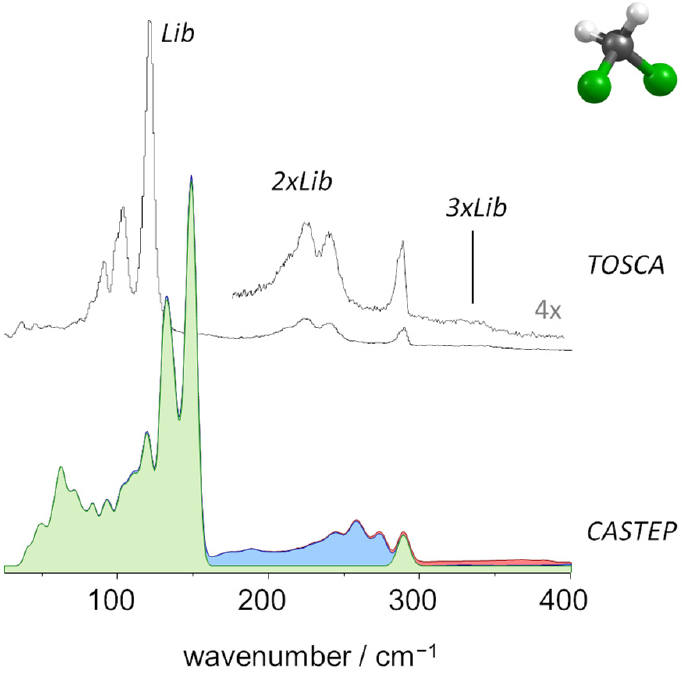
Figure 5. Detailed view of the INS spectra of dichloromethane in the low wavenumber region, up to 400 cm − 1 : Experimental (top, TOSCA) and simulated from periodic calculations (bottom, CASTEP). Colors indicate the intensity contributions from fundamental modes (green), two-quanta events (blue) and three-quanta events (red).